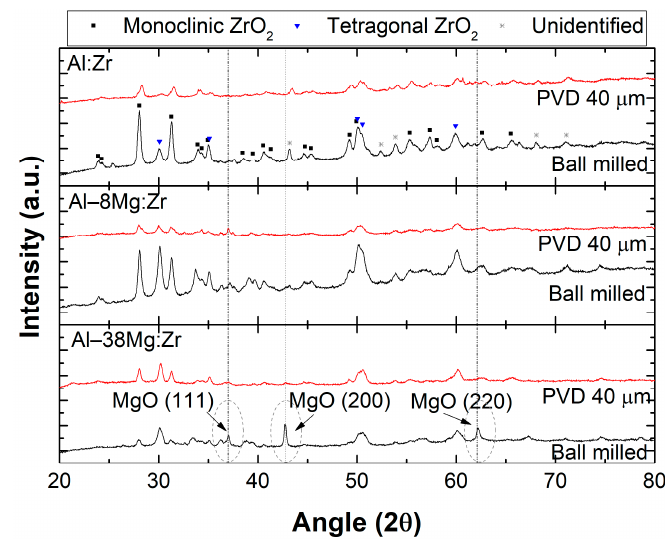
Figure 7. X-ray diffraction data for Al:Zr, Al–8Mg:Zr, and Al–38Mg:Zr particles collected within the reaction crucible.